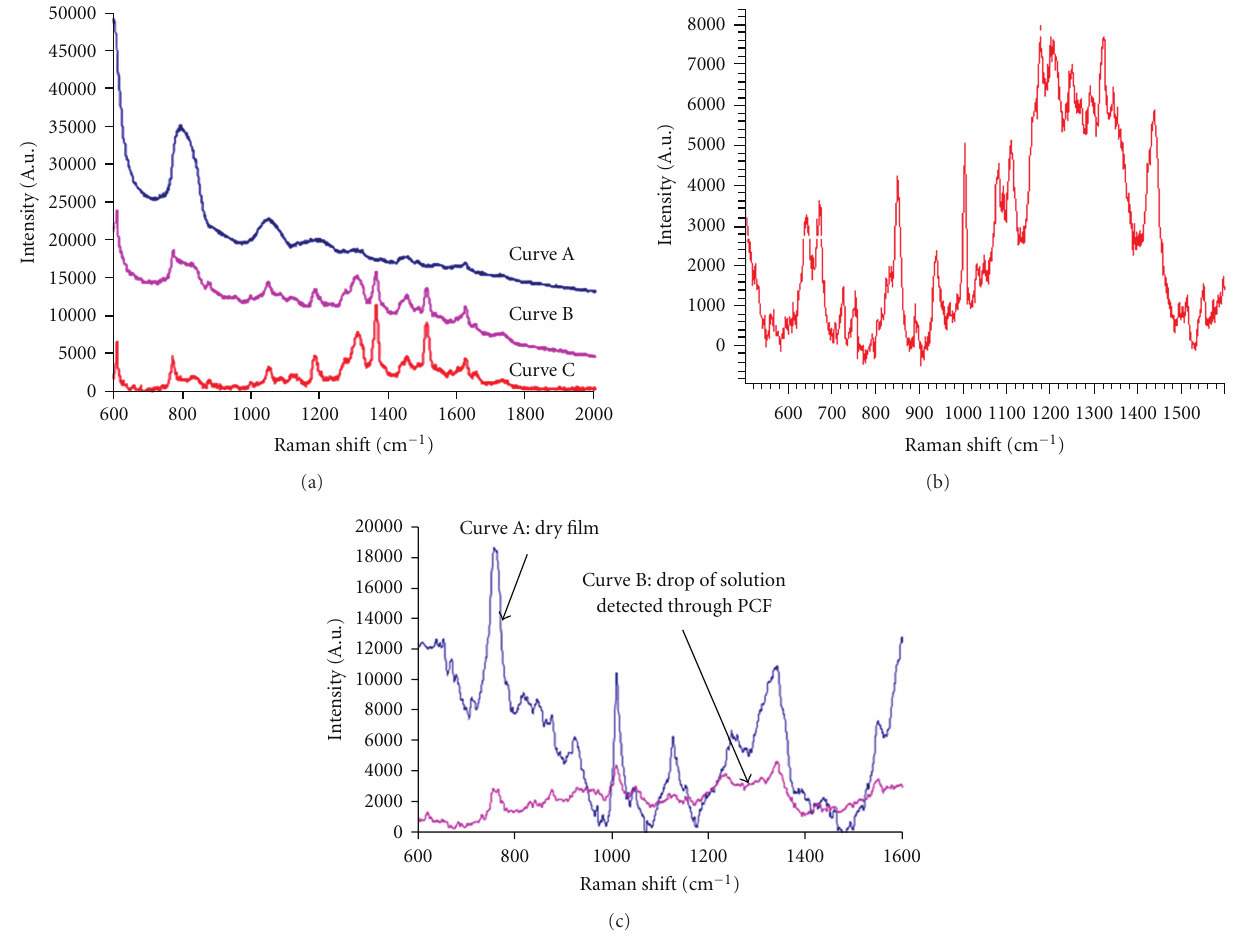
Figure 5: (a) Curve A: background Raman spectrum of the HCPCF. Curve B: R6G Raman spectrum obtained using a HCPCF SERS probe without the postfabrication processing; the HCPCF was dipped into the nanoparticle/R6G solution. Curve C: subtraction of Curve A from Curve B showing the net R6G Raman signal. (b) Human insulin SERS spectrum obtained using a LCPCF SERS probe after the postfabrication processing. The fiber background has been subtracted. (c) Comparison of SERS intensities between tryptophan obtained from the postprocessed LCPCF SERS probe and that obtained directly from a dried nanoparticle/analyte